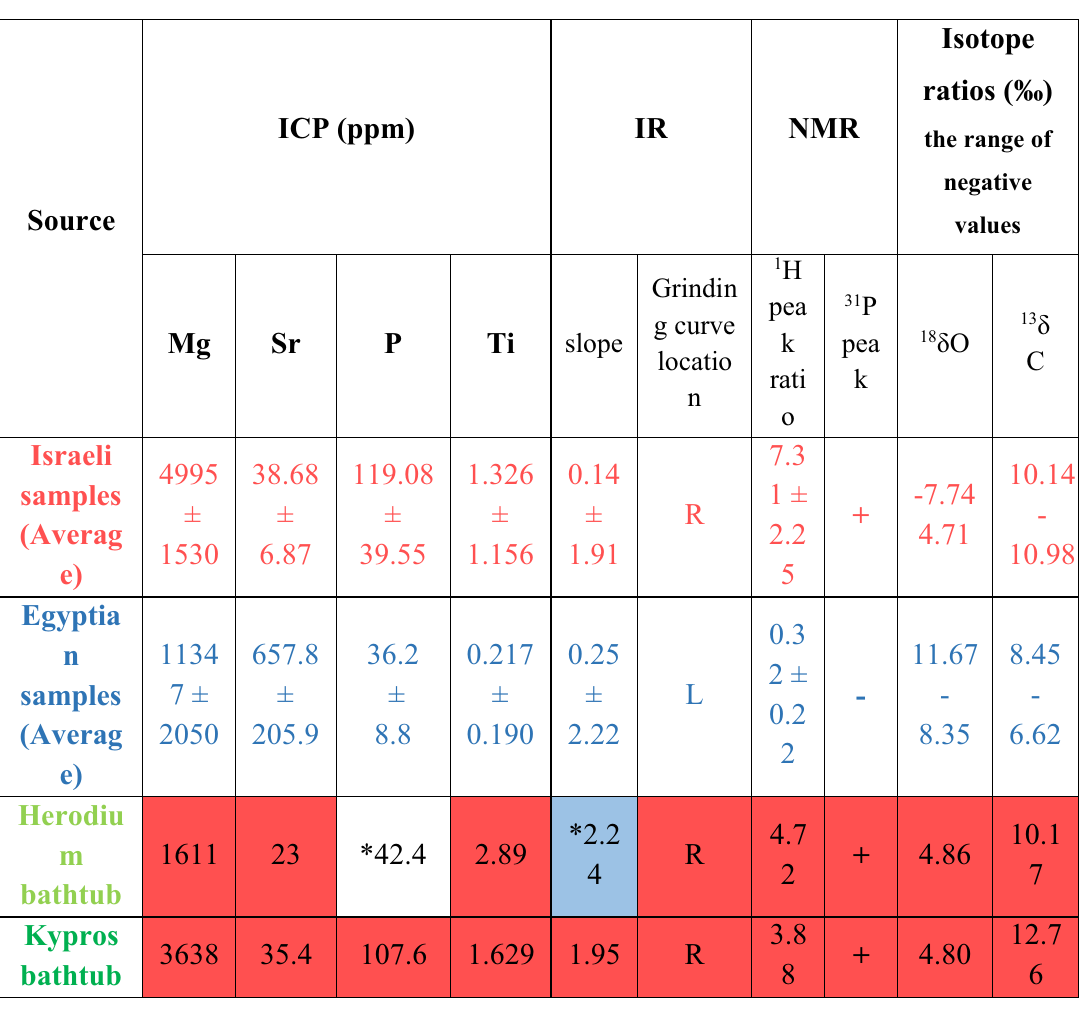
Table 3. Israeli samples in red, Egyptian samples in blue. The color coding of the cells in the table showing bathtub samples indicates their similarity to the corresponding values of the "known" Israeli and Egyptian samples. *see